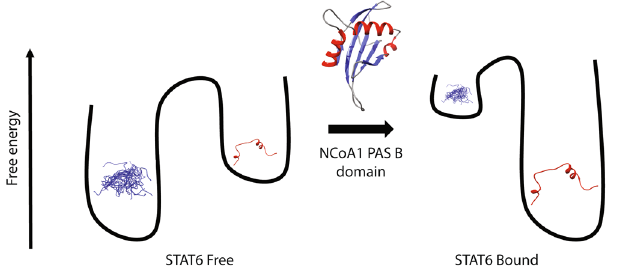
Figure 8. Molecular recognition mechanism. Cartoon representation of the conformational selection mechanism. The binding of the coactivator changes the free-energy landscape of STAT6 783–814